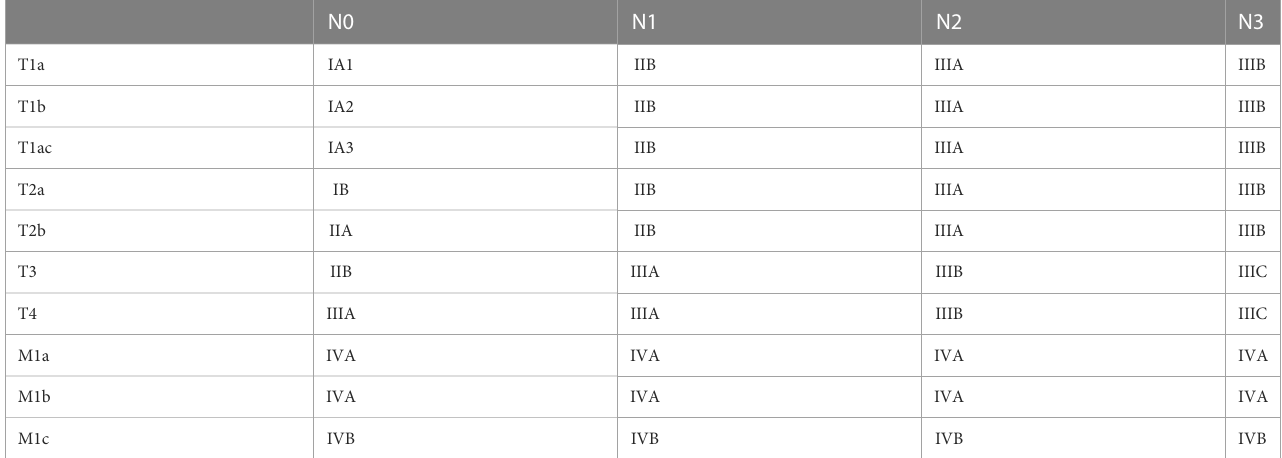
TABLE 1 NSCLC staging in AJCC Cancer Staging Manual, 8th